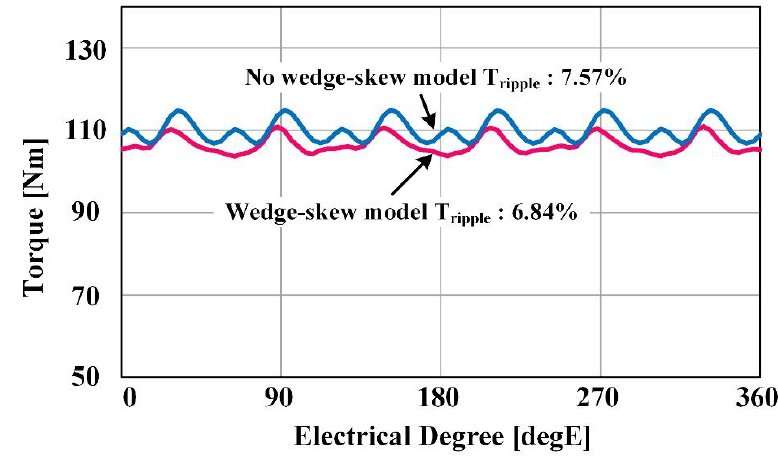
Figure 13. Torque wave form of final model.